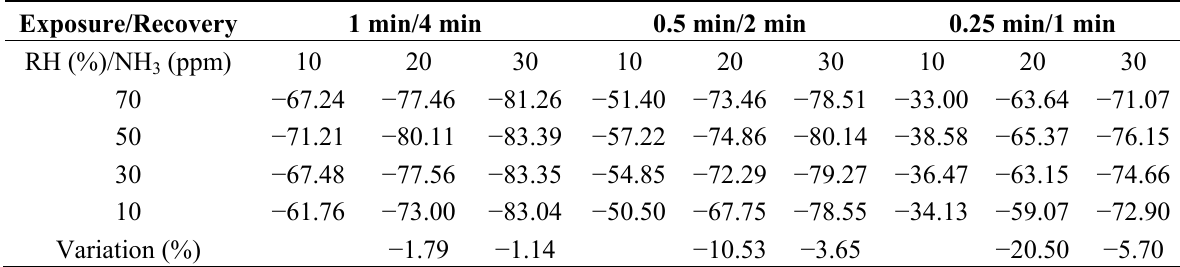
(%)) to NH depending on the relative humidity for the Table 1. Relative response ( ΔI/I 0 3 different exposure/recovery protocols. The variations (in %) between the responses to two consecutive NH concentrations were calculated for each exposure/recovery protocol, 3 from the minimum relative response to a NH concentration minus the maximum relative 3 response of the immediately lower